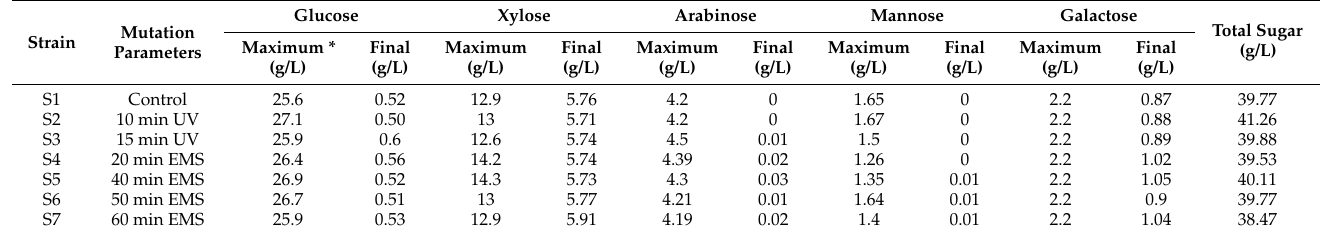
Table 1. Maximum individual sugar concentrations consumed by mutated strains during SSF of